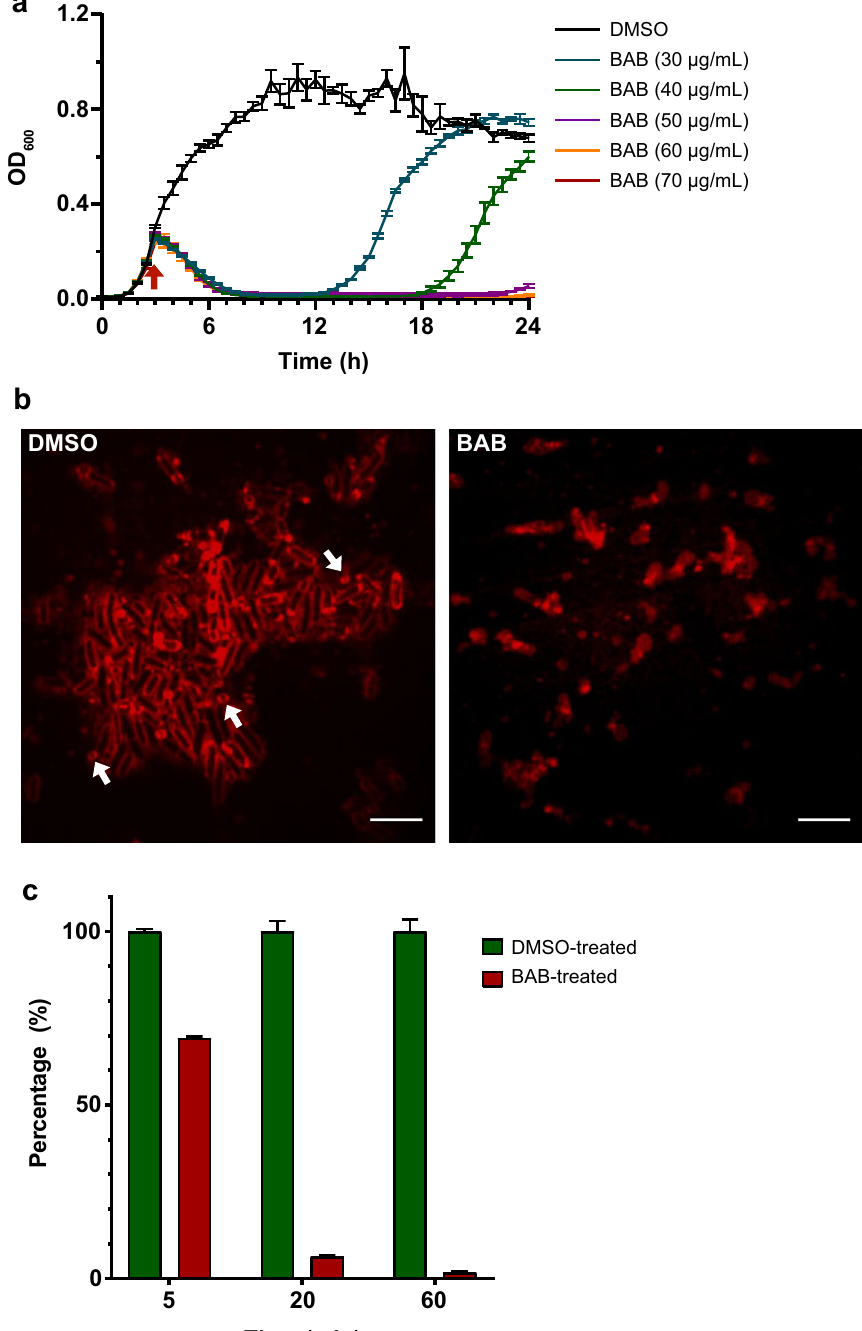
Figure 5. Antimicrobial properties of BAB. ( a ) Growth curves of B. subtilis in the presence of a range of BAB concentrations. OD 600 was measured every 30 min. BAB was added at 2 h 45 min (arrow indicated). The graph depicts the average and the SEM of biological triplicates. ( b ) No sporulation in response to BAB. B. subtilis cells from high intensity overnight culture were treated with DMSO (control) or BAB (250 μg/mL, 5 × MIC), stained with FM4-64 and imaged by confocal fluorescence microscopy. Representative images are shown. Example spores in the DMSO control are indicated with arrows. Scale bar is 5 µm. ( c ) Effect on respiratory chain activity measured by the reduction from blue resazurin to red resorufin at 540 nm. The average intensity of DMSO control in each group was set as 100% intensity and the percentage of each treated sample was calculated. The mean from biological triplicates was plotted with error bars representing the